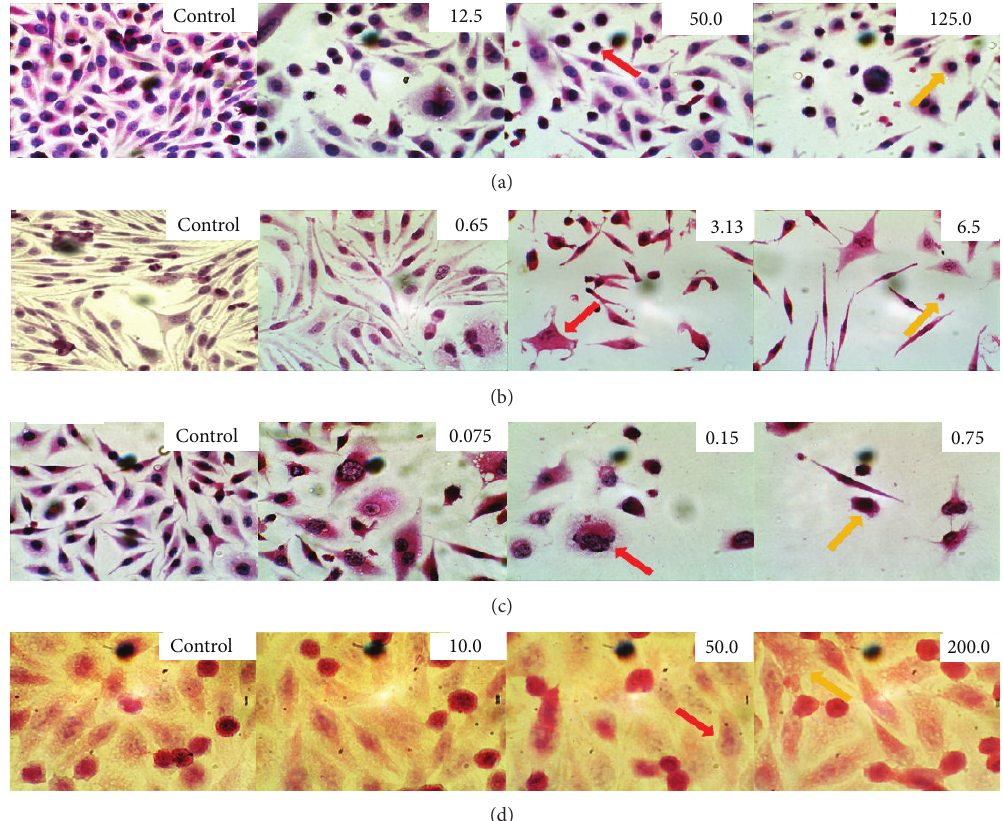
Figure 3: Cellular effects of ranibizumab (a), bevacizumab (b), pegaptanib (c), and aflibercept (d) on L929 cells. Cells shown are at Day 5 of various treatment concentrations (H&E staining, magnification ×